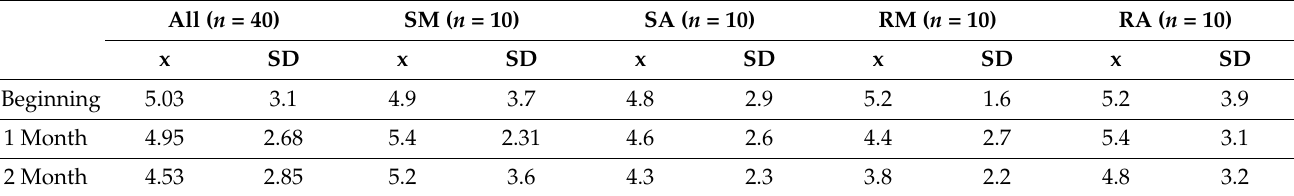
Table 7. Attached keratinized gingival.